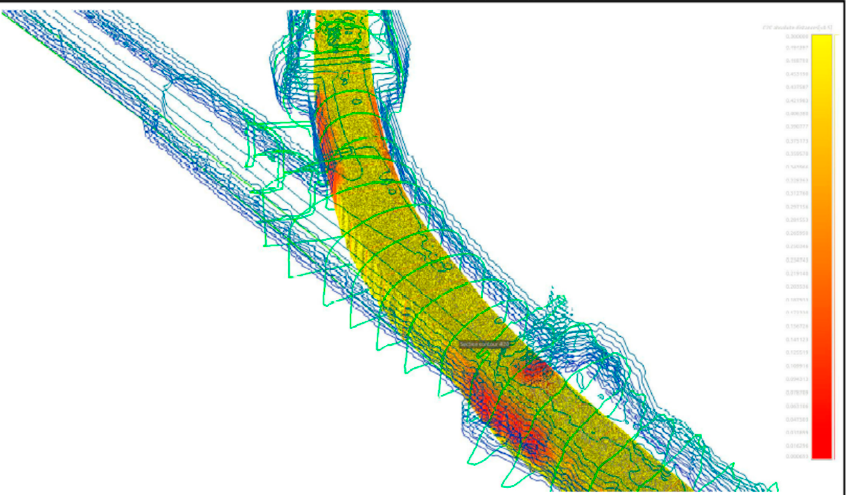
Figure 11. Three-dimensional model for the purpose of analysis of collision in underground mine workings possibility (Reprinted from Ref. [69]).